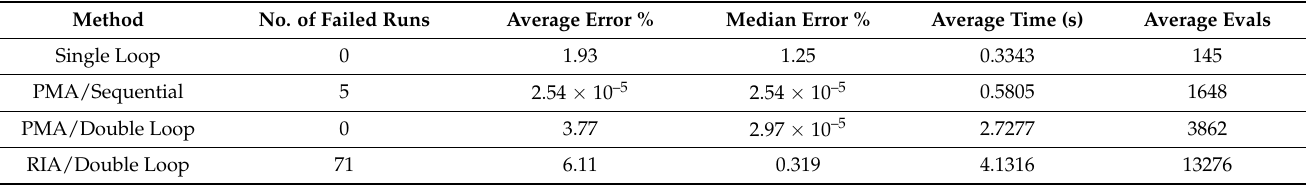
Table 2. Stability comparison of different